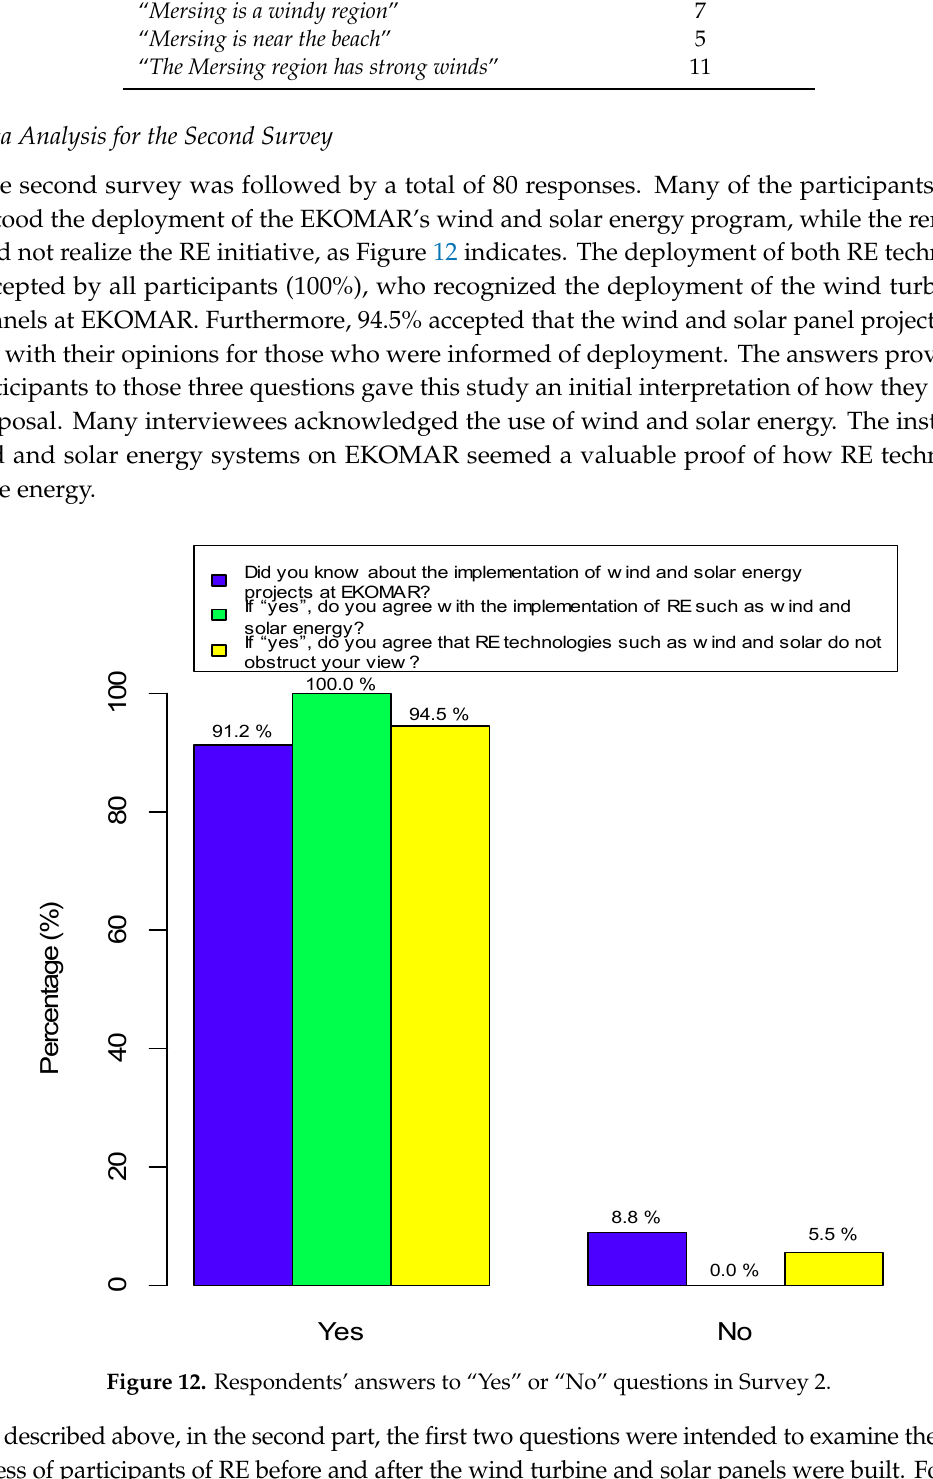
Figure 13. Respondents’ general knowledge of RE before and after RE implementation at EKOMAR. Consequently, questions regarding the benefits of RE technologies, such as wind and solar resources, were asked to the participants. As seen in Figure 14, participants accepted that RE